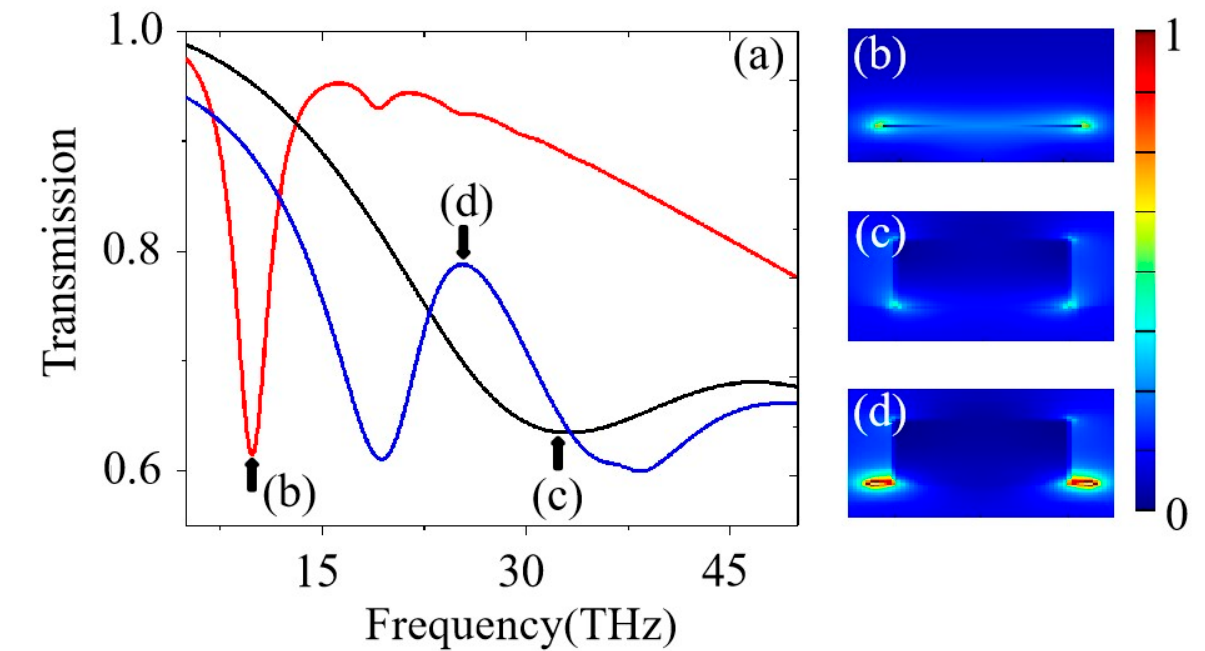
Figure 2. ( a ) The red line is the spectra when there is only a BP layer on the surface of SiO 2; the black line is the spectra when there is only a MXene nano-rod on the surface of SiO 2; the blue line is the spectra of the proposed composite MXene/BP metasurface. ( b ) The electric field at the frequency of 9.75 THz. ( c ) The electric field at the frequency of 32.54 THz. ( d ) The electric field at the frequency of 25.34 THz.